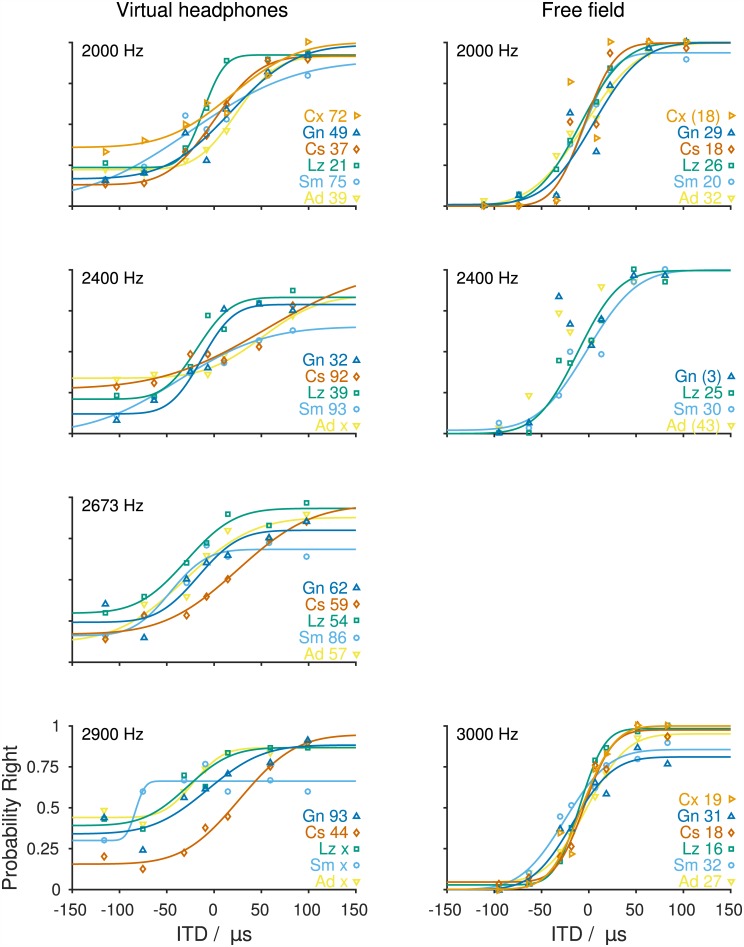
Probability of responses to the right as a function of ITD at frequencies ≥2000 Hz. The left column shows the performance using virtual headphones. The right column shows the free-field performance depending on the ITDs occurring in the free-field experiments.Tones with frequencies of 2000 [n = 6 (vhp, free-field)], 2400 [n = 5 (vhp) and 4 (free-field)], 2673 (n = 5, vhp only), 2900 Hz (n = 5, vhp only), and 3000 Hz (n = 6, free-field only) were presented. Symbols and lines as in the previous figure. Thresholds (in μs) and identifiers of individual animals are given on the right. ‘x’ indicates that no threshold could be determined because the threshold criterion was not reached. Thresholds in brackets were derived from cumulative normal distribution functions that yielded R2<0.875 with the raw data and not used in further analyses; such cumulative normal distribution functions are not shown.